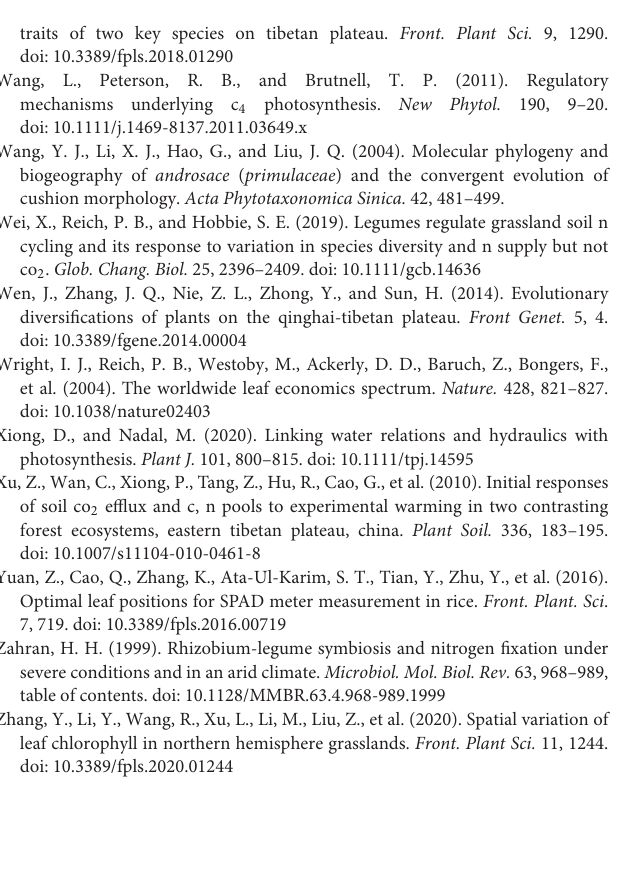
table of contents. doi: 10.1128/MMBR.63.4.968-989.1999 Zhang, Y., Li, Y., Wang, R., Xu, L., Li, M., Liu, Z., et al. (2020). Spatial variation of leaf chlorophyll in northern hemisphere grasslands. Front. Plant Sci. 11, 1244. doi: